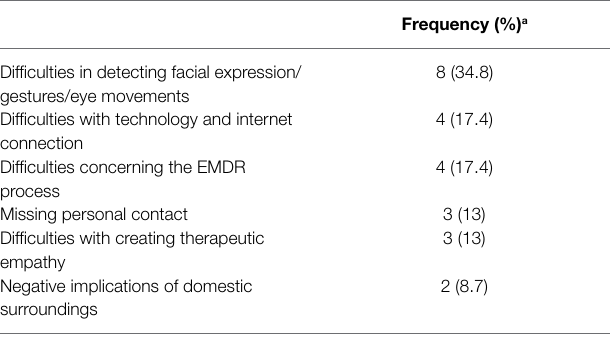
TABLE 5 | Frequencies of perceived disadvantages in eEMDR sessions compared to face-to-face EMDR